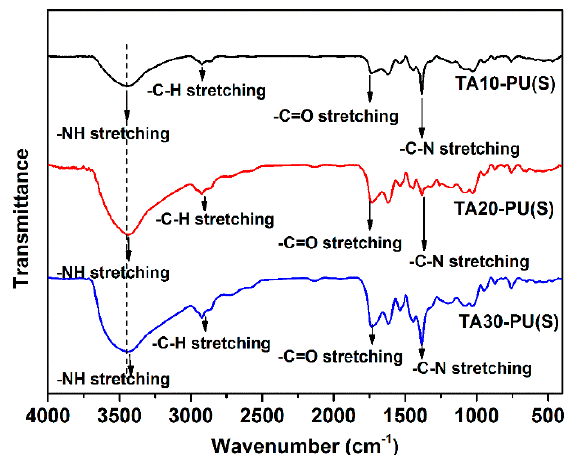
Figure 1. FTIR spectra of TA10–PU(S), TA20–PU(S), and TA30–PU(S) dry Figure 1 . FTIR spectra of TA10–PU(S), TA20–PU(S), and TA30–PU(S) dry gels.